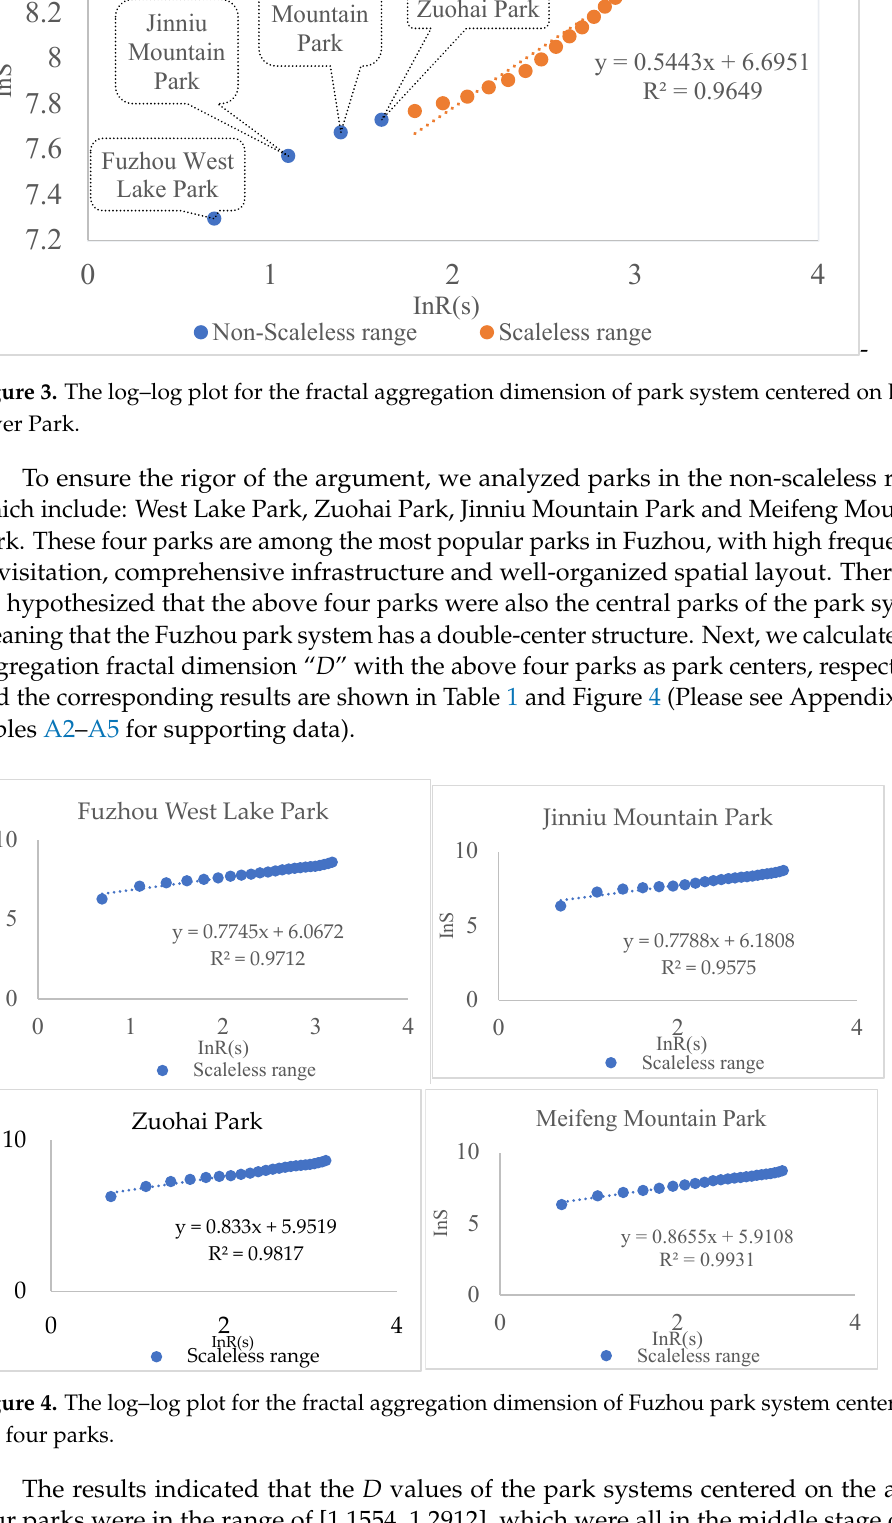
Figure 4. The log–log plot for the fractal aggregation dimension of Fuzhou park system centered on the four parks. The results indicated that the 𝐷 values of the park systems centered on the above four parks were in the range of [1.1554, 1.2912], which were all in the middle stage of the DLCA model, indicating that the four parks were also the centers of the park systems. The spatial distribution of the park system followed a density decay from the center to the periphery, accompanied by a gradual decrease in the attractiveness of the center. Since the aggregation dimension 𝐷 can reflect the development level of the system, we sug- gested that by assuming different parks as the center of the system, if the assumptions all hold, 𝐷 can reflect the attractiveness level and dominance of the park. Therefore, the or- der of the adsorption effect of the central park on the general park was: Fuzhou West Lake Park ( 𝐷 = 1.2912 ) > Jinniushan Park ( 𝐷 = 1.82840 ) > Zuohai Park ( 𝐷 = 1.2005 ) > Meifeng Mountain Park ( 𝐷 = 1.1554 ). Since the four parks are closely distributed and have similar development levels, we deem that the four parks form a central cluster, which has been referred to as the Four-Park Cluster. There is a construction principle for all classical frac- tals, which has a self-similar infinite nested structure. Combined with the aggregation fractal dimension values of the five parks, we concluded that the hypothesis that there are multiple centers in the Fuzhou comprehensive park system holds true, with the centers being Baima River Park and the Four-Park Cluster, respectively. 3 . 2 . Analysis of System Spatial Balance Based on Grid Dimension The grid dimension reflects the rate of coverage of parks in the city, and the increase indicates that the balance degree and filling degree of the parks increased. The selection of a rectangle on the vector map of the spatial distribution of the park system, which con- tains 24 park samples, changes the visible rectangular area into a unit, and each side of K is divided equally. The calculation of the probability P i j (r), with a change in the r value, enables the determination of the corresponding K(r) and Pi values, and the correspond- ing I (r) can be obtained using Formula (5) (Table 2). Next, the grid dimension calculation data were obtained from Formulas (5) and (6), and ((ln K ,ln N ) and (lnK,lnI(r)) were drawn, leading to the transformation of (lnK,lnN) and (lnK,lnI(r)) into a double log- arithmic coordinate map (please see Appendix B of Tables A6 and A7 for supporting data). The grid capacity dimension 𝐷 (cid:2868) and grid information dimension 𝐷 (cid:2869) are then de- termined (Table 3). Table 2. The determining dates of grid dimension of the Fuzhou park system. K